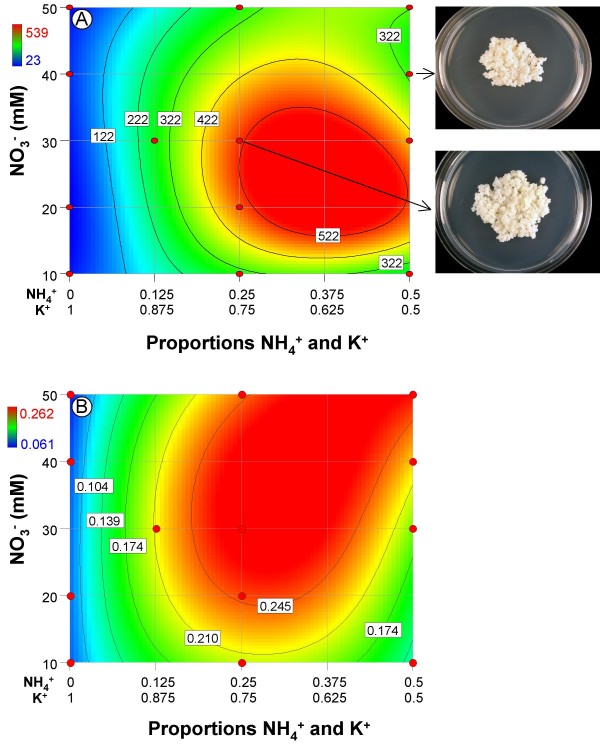
Fresh and dry weight response contour plots for embryogenic tissue. A) % increase in fresh weight growth; B) dry weight. The standard MS point and the point of greatest growth are indicated on each plot.